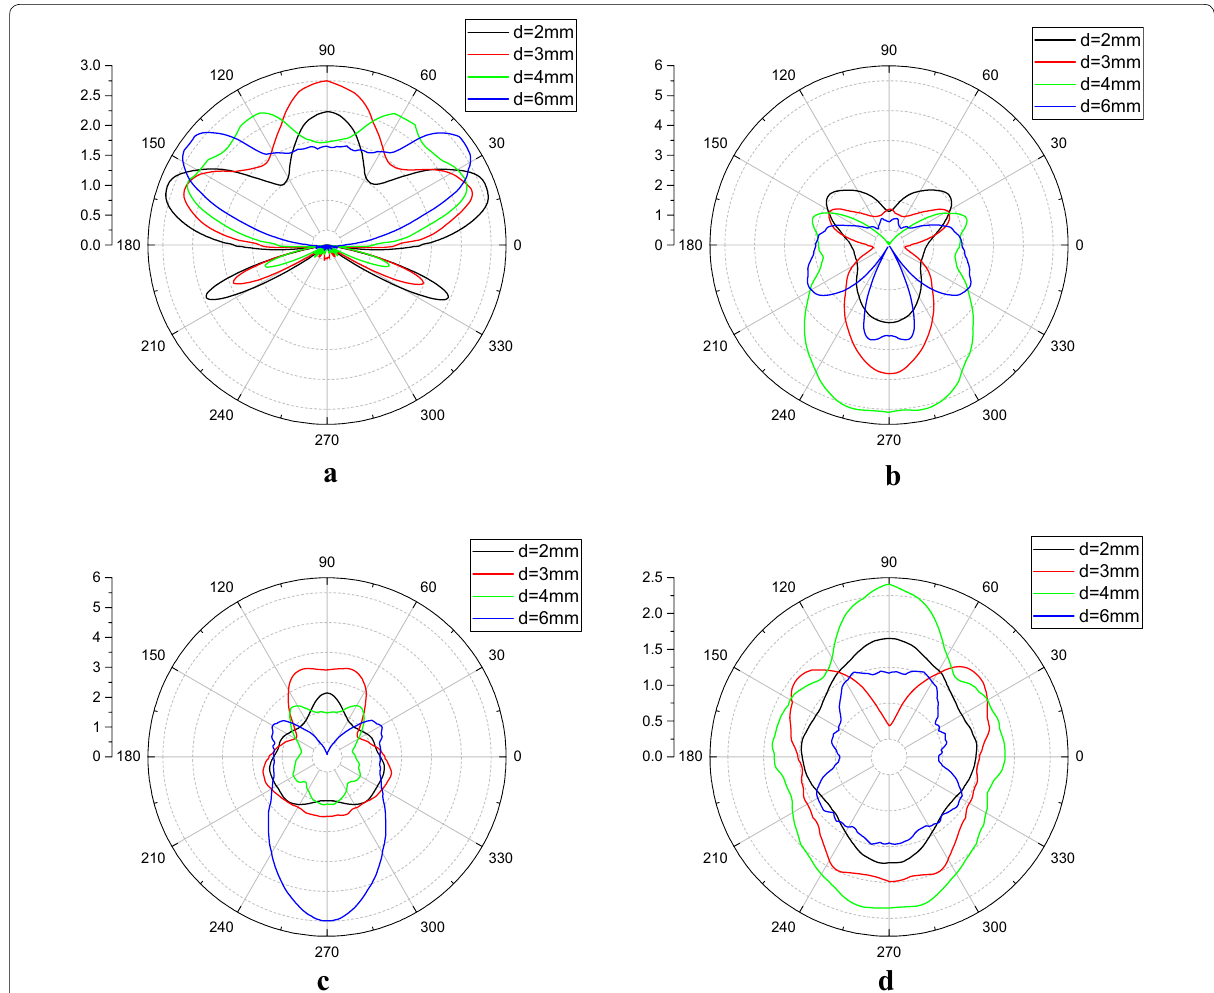
Figure 8 Pressure distributions of the ultrasonic wave propagating at various instants, which show the scattered filed amplitude behavior when the distances between two cylinders are 2, 3, 4, and 6 mm: a t